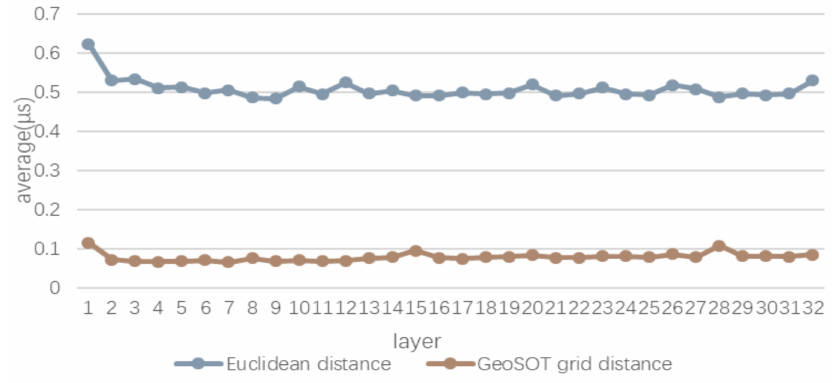
Figure 16. Average time for spatial distance measurement.